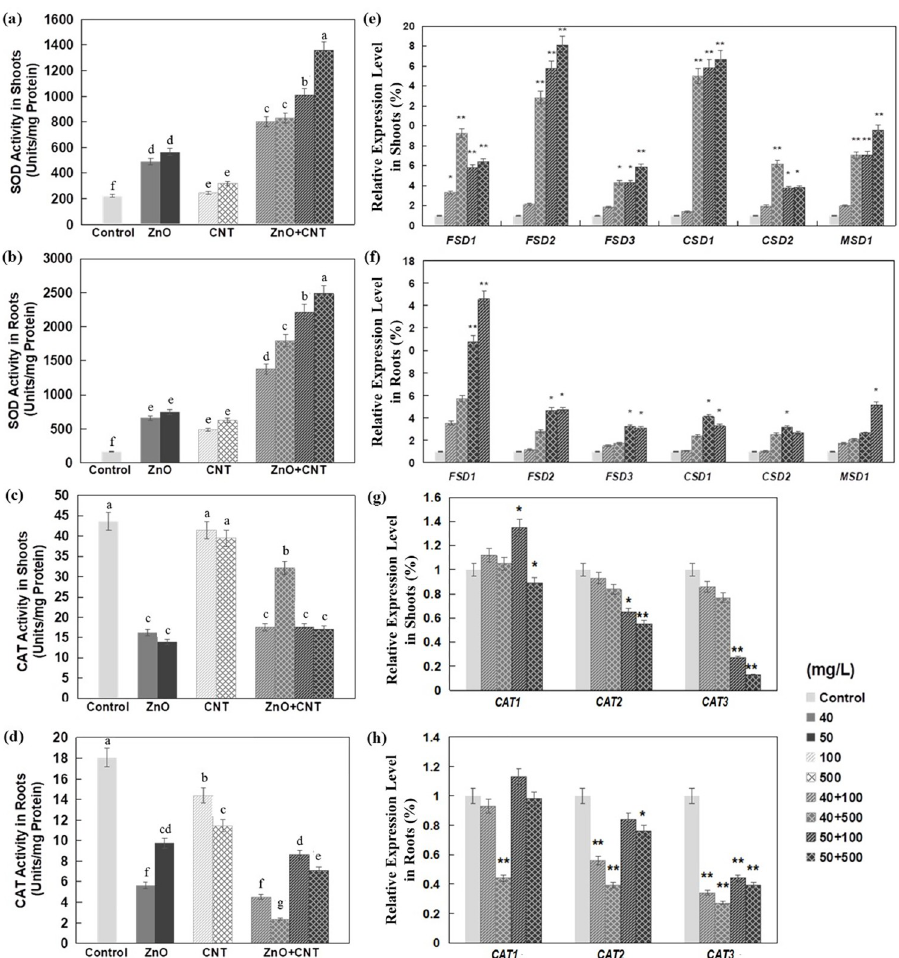
Fig 4. Effect of ZnO NPs and MWCNTs, alone or in combination, on enzyme activity and expression levels of genes encoding enzymes in Arabidopsis seedlings at 10 DAG. (a) SOD activity in shoots. (b) SOD activity in roots. (c) CAT activity in shoots. (d) CAT activity in roots. (e) Relative expression levels of genes encoding multiple SOD isoforms in shoots. (f) Relative expression levels of genes encoding multiple SOD isoforms in roots. (g) Relative expression levels of genes encoding multiple CAT isoforms in shoots. (h) Relative expression levels of genes encoding multiple CAT isoforms in roots. Level of gene expression in control seedlings was set to 1. Data are the means ± standard errors of three replicates. Different letters indicate a significant difference between treatments ( P < 0.05, by Duncan test). � P < 0.05 and �� P < 0.01 compared with control plants (by Student’s t -test).